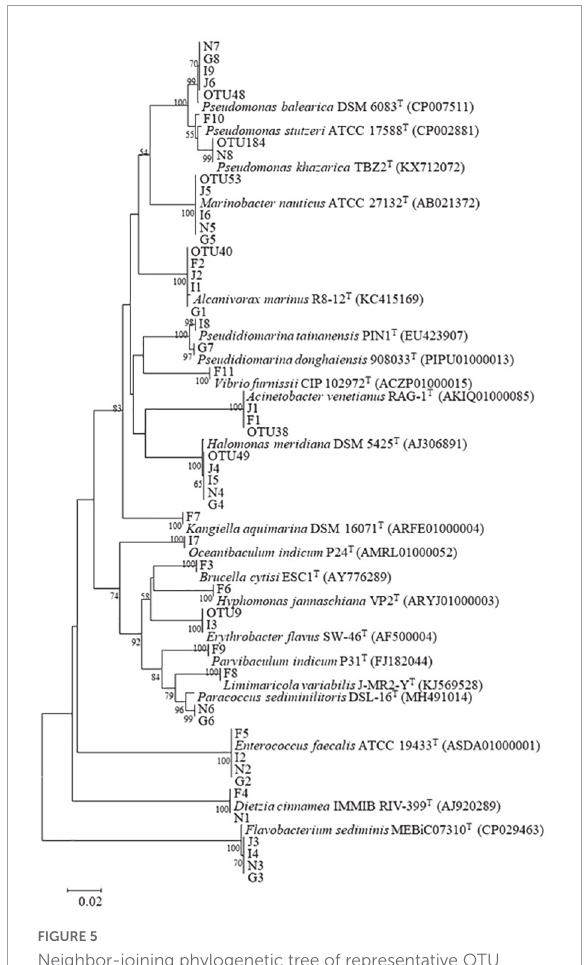
FIGURE5 Neighbor-joining phylogenetic tree of representative OTU sequences, isolates, and their related species. Bootstrap values (expressed as percentages of 1,000 replications) greater than 50% are shown at branch points. Bar, 0.05 substitutions per nucleotide position. Accession numbers are given in